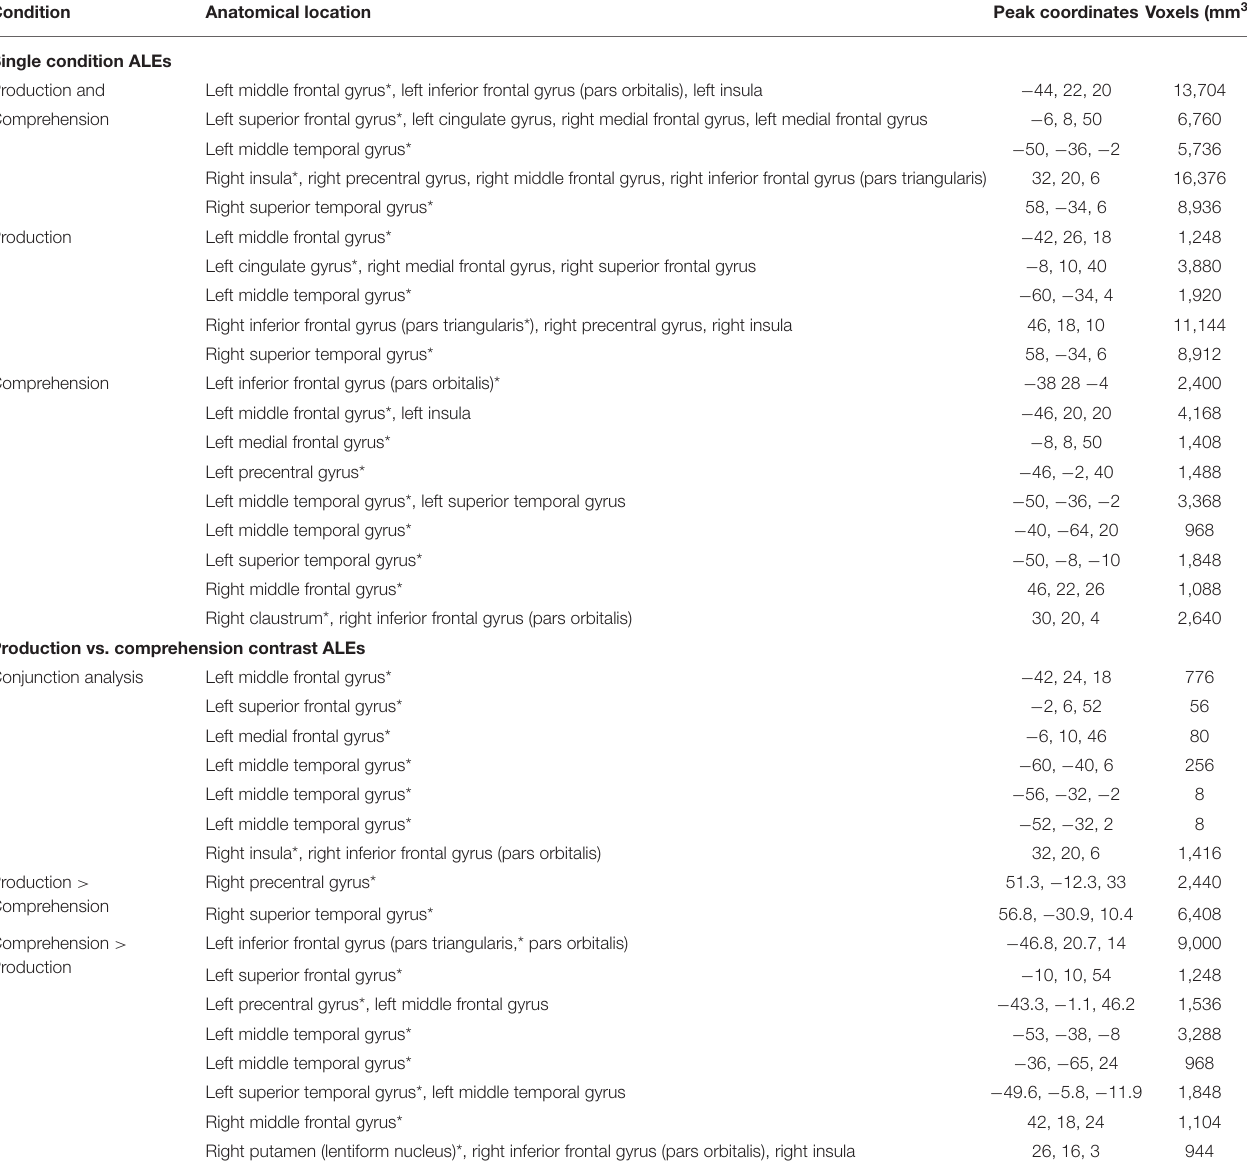
TABLE 2 | Anatomical locations of peak coordinates and cluster size for each single condition and contrast ALE in PWA.